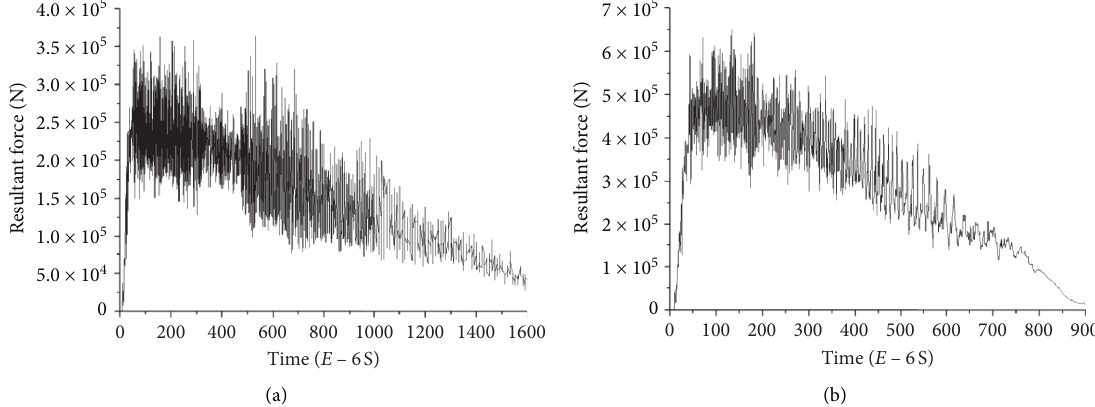
Figure 10: Contact force-time curves of penetrating concrete and stone at 1000m/s. (a) Contact force-time curve of concrete penetration. (b) Contact force-time curve of stone